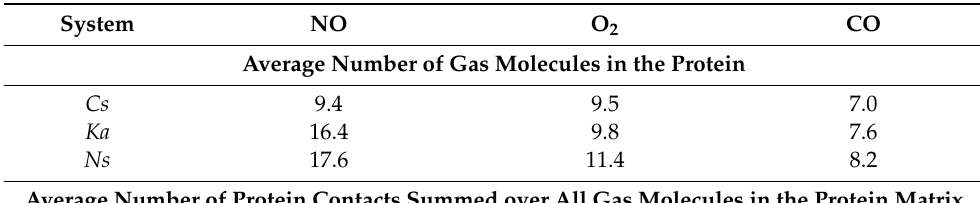
Table 2. Global descriptors of gas molecules–protein interactions derived from the MD trajectories for bacterial H-NOX